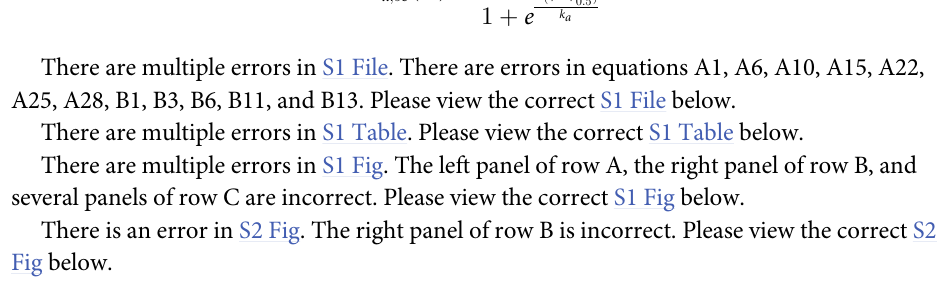
S1 File. Model equations. List of equations used to model the channel currents. S1 Table. Model parameters. Fitted parameters, as identified by least-squares nonlinear fitting (or by genetic algorithm in the case of SLO channels, see Methods) are reported. Correspond- ing steady-state activation/inactivation and time constant functions, computed with the fitted parameters, are shown in S1–S5 Figs. We refer the reader to the modeled equations (Eqs 12– 19, 26–29, and A-C in S1 File) explicitly including the fitted parameters. Some channel contri- butions (SHL1, KVS1, KQT3, EGL2, EGL19, UNC2, CCA1) were modeled based on homolo- gous channels in species different from C . elegans or on muscle cells. To include these